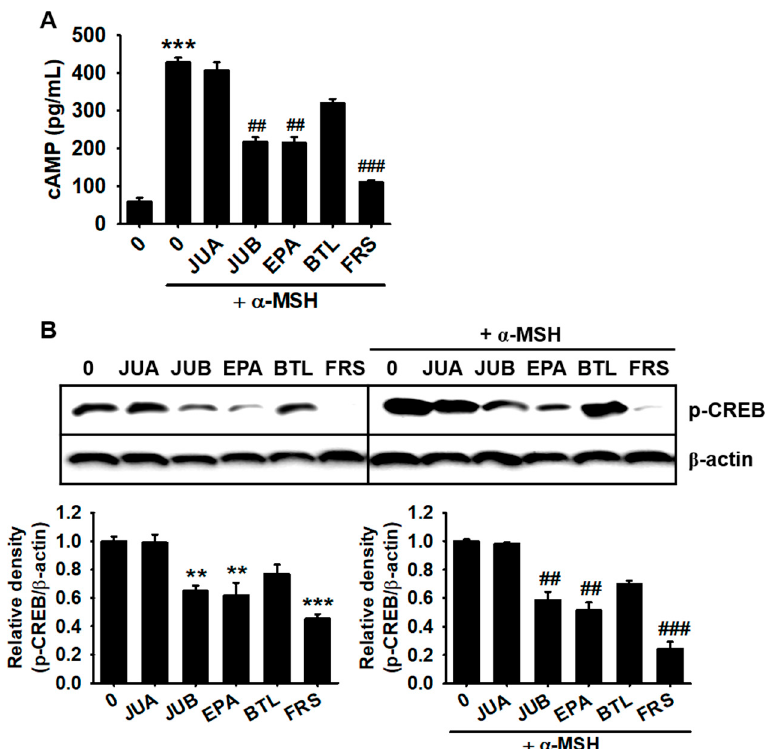
Figure 6. JUB, BTL, and FRS from Z. jujuba var. inermis (Bunge) Rehder seed inhibit cAMP levels and subsequent CREB phosphorylation. B16F10 melanoma cells (5 × 10 4 cells/mL) were treated with 20 µM of jujuboside A (JUA), jujuboside B (JUB), epiceanothic acid (EPA), betulin (BTL), and 6’’’- feruloylspinosin (FRS) in the presence and absence of 500 ng/mL of α -melanocyte-stimulating hormone ( α -MSH). ( A ) Cyclic adenosine monophosphate (cAMP) levels were quantified at 15 min by enzyme-linked immunosorbent assay. ( B ) Western blotting was performed at 96 h to evaluate the expression of phosphorylated cAMP response element-binding protein (CREB). β -Actin was used as the internal control. Relative densities were calculated using ImageJ software and intensity levels were normalized to those of β -actin. All data are presented as standard errors of the median from three independent experiments (*** p < 0.001 and ** p < 0.01 vs. untreated cells; ### p < 0.001 and # # p < 0.01 vs. α -MSH-treated cells).